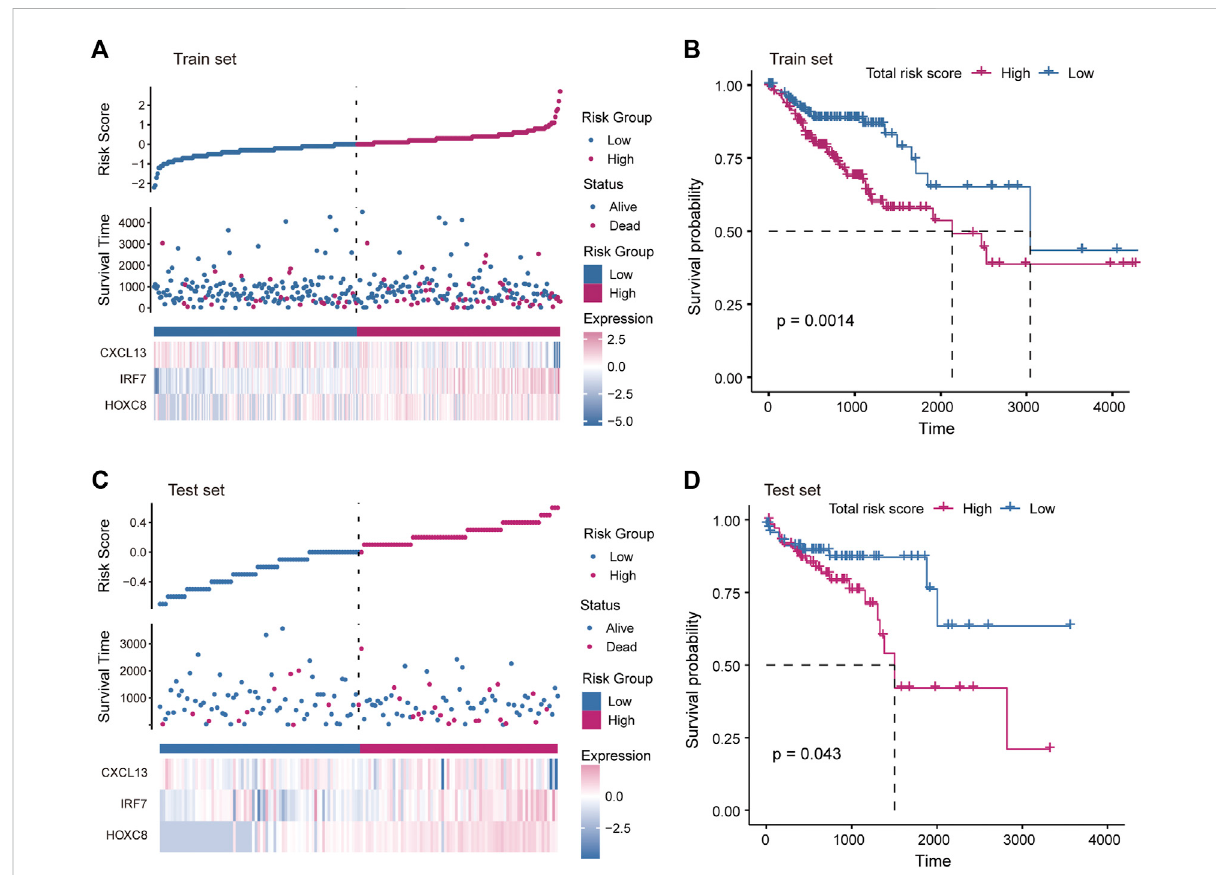
FIGURE 5 Construction of risk scoring model. (A) The fi gure shows the risk scores, survival status, and expression of prognostic markers for the train set samples. (B) TheKaplan-Meiercurvesforthesurvivalofhigh-riskandlow-riskgroupsinthetrainset. (C) Sameasin (A) butforthetestsetsamples. (D) Same as in (B) but for two groups in the test